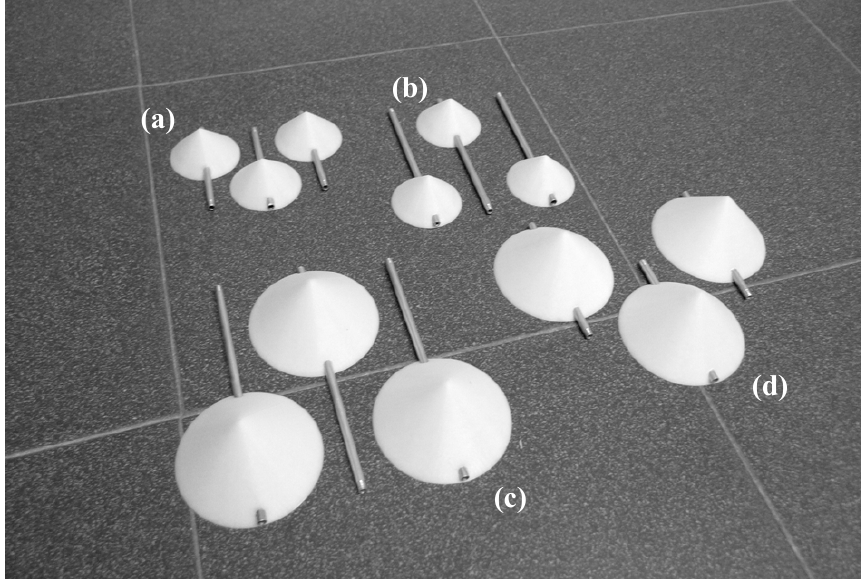
Figure 6. Cups sets correspondent to the 50/60 ( a ), 50/100 ( b ), 80/120 ( c ) and 80/60 ( d ) rotors (see in Table 1 the characteristics of each rotor